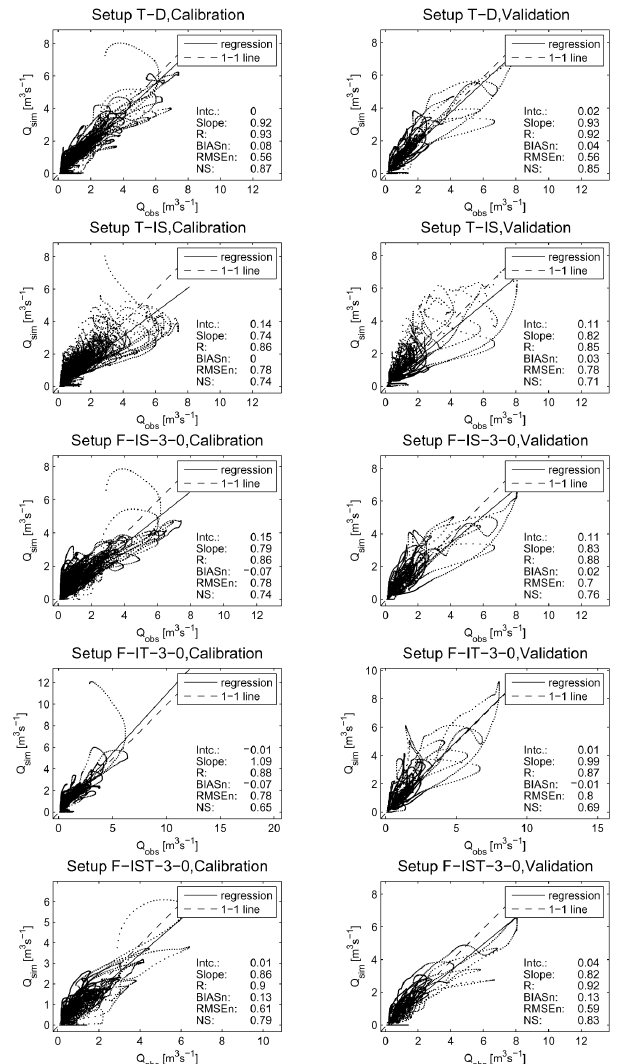
Fig. 9. Scatter plots of observed and simulated discharge in catch- ment Oostkamp–Rivierbeek for calibration set-ups T-D (1), T-IS (2), F-IS-3-0 (3), F-IT-3-0 (4) and F-IST-3-0 (5) in the calibration (left) and validation (right)